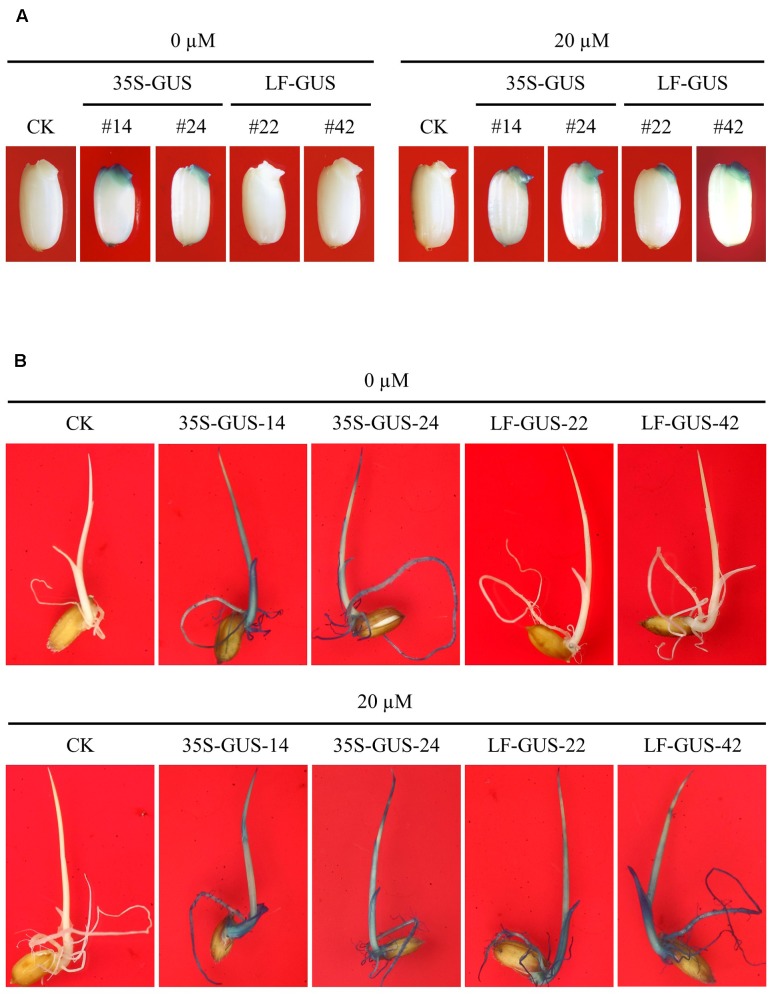
Induced GUS expression in germinating embryos and seedlings of LF-GUS transgenic rice. (A) GUS staining of rice seeds soaked in 0 or 20 μM estradiol for 3 days. CK, non-transgenic wild type control; 35S-GUS-14 and 35S-GUS-24, pCAMBIA1305-transformed rice line #14 and #24; LF-GUS-22 and LF-GUS-42, pXCLF-GUS-transformed rice line #22 and #42. (B) GUS staining of seedlings developed from seeds soaked and germinated in liquid solution with 0 or 20 μM estradiol.